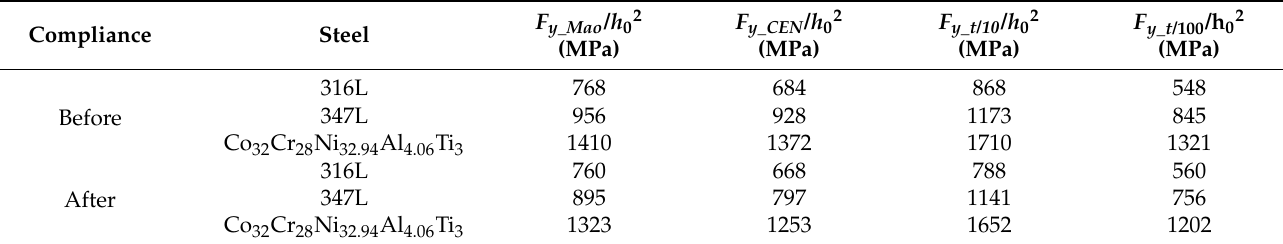
Table 6. Characteristic force of the SPT curve determined by different methods before and after compliance calibration (yield